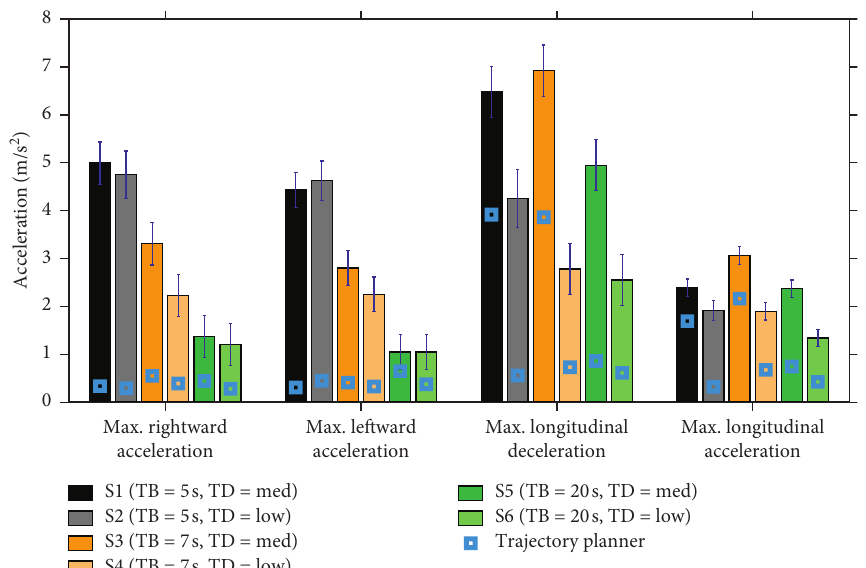
Figure 7: Means of the maximum acceleration values for the six scenarios. The blue markers represent the values of the trajectory planner. Error bars indicate standard errors.